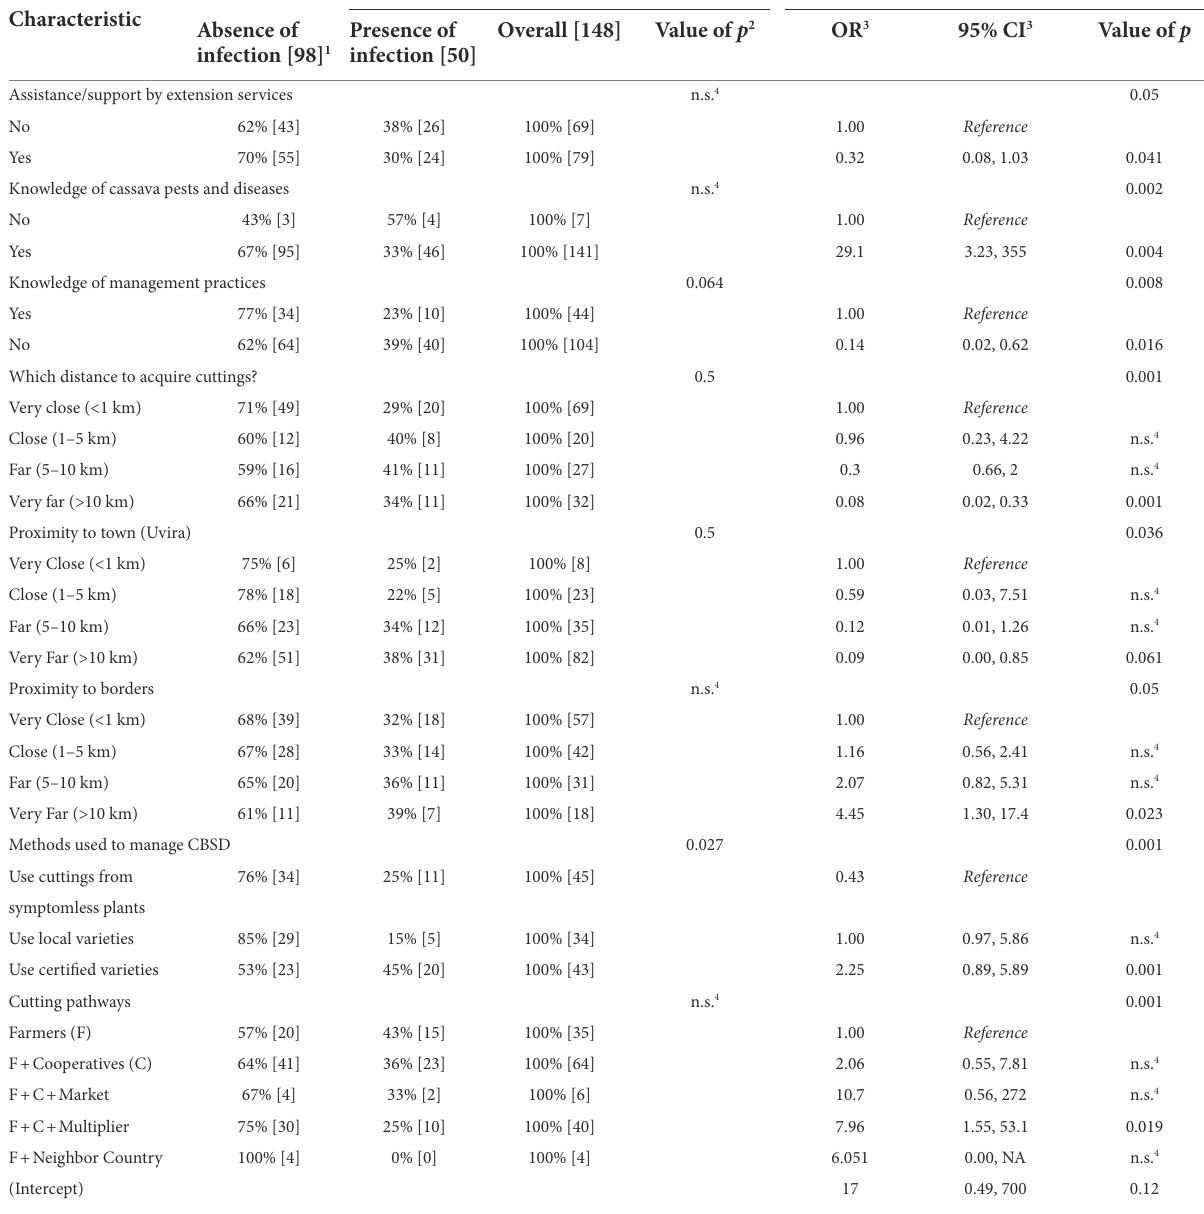
TABLE 8 Prediction of risk factors associated with CBSD (based on RT-PCR